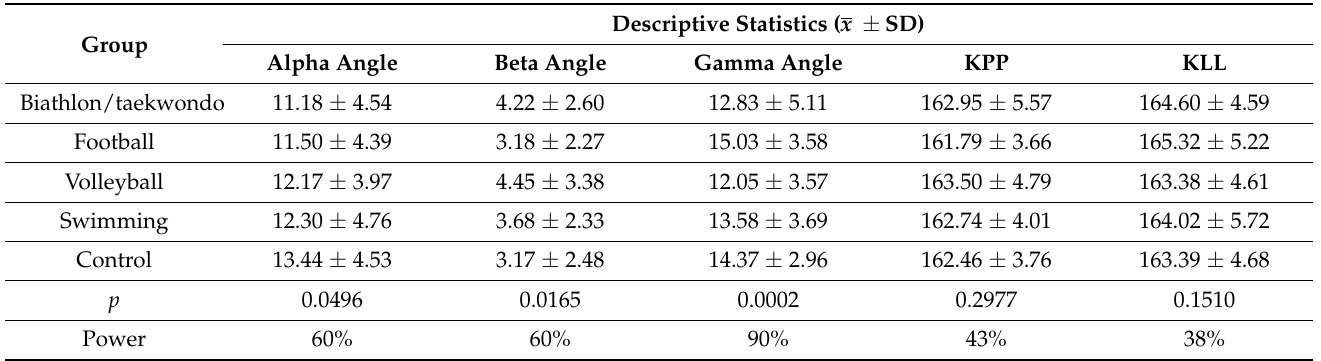
Table 2. Characteristics of the Alpha, Beta and Gamma parameters.